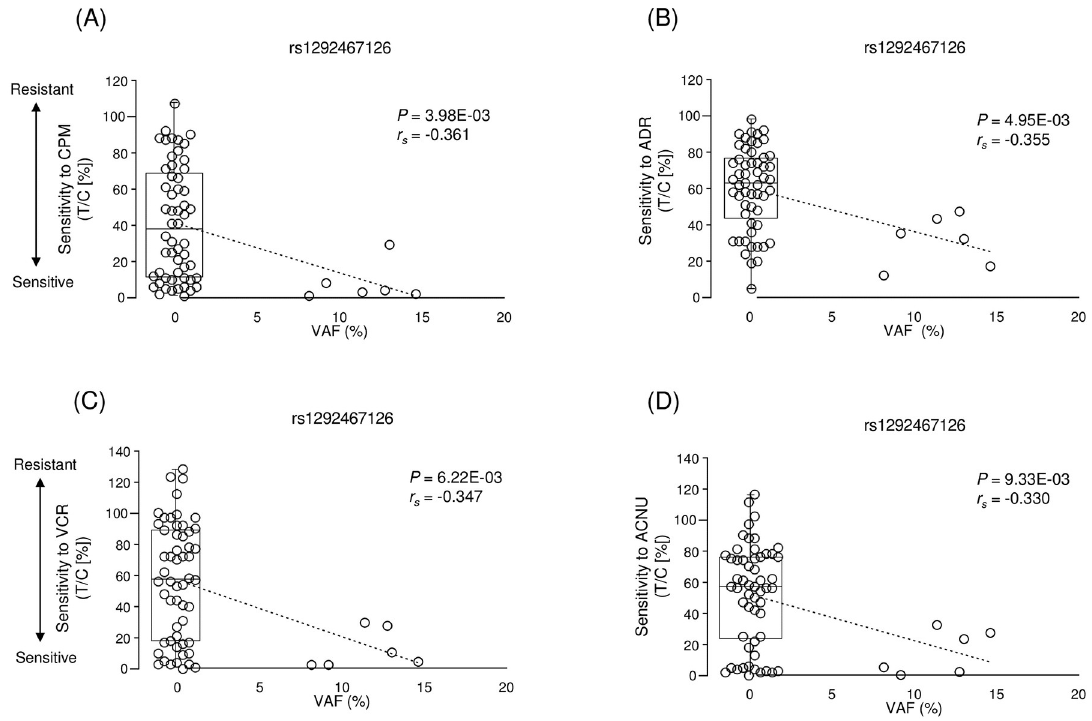
Fig 2. Correlation between variant rs1292467126 and chemosensitivity to CPM (A), ADR (B), VCR (C), and ACNU (D). Chemosensitivity to each drug is represented by relative tumor volume of treated mice (T) with respect to that of the control mice (C). rs1292467126 was commonly associated with increased sensitivity to four of the nine tested anticancer drugs.